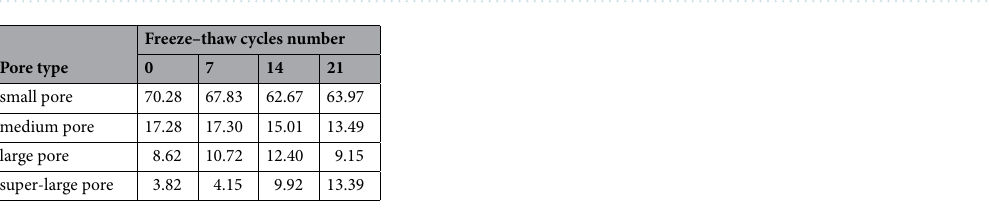
Figure 9. Triaxial compression failure mode of sandstone. ( a ) 0 freeze–thaw cycles. ( b ) 7 freeze–thaw cycles. ( c ) 14 freeze–thaw cycles. ( d ) 21 freeze–thaw cycles.